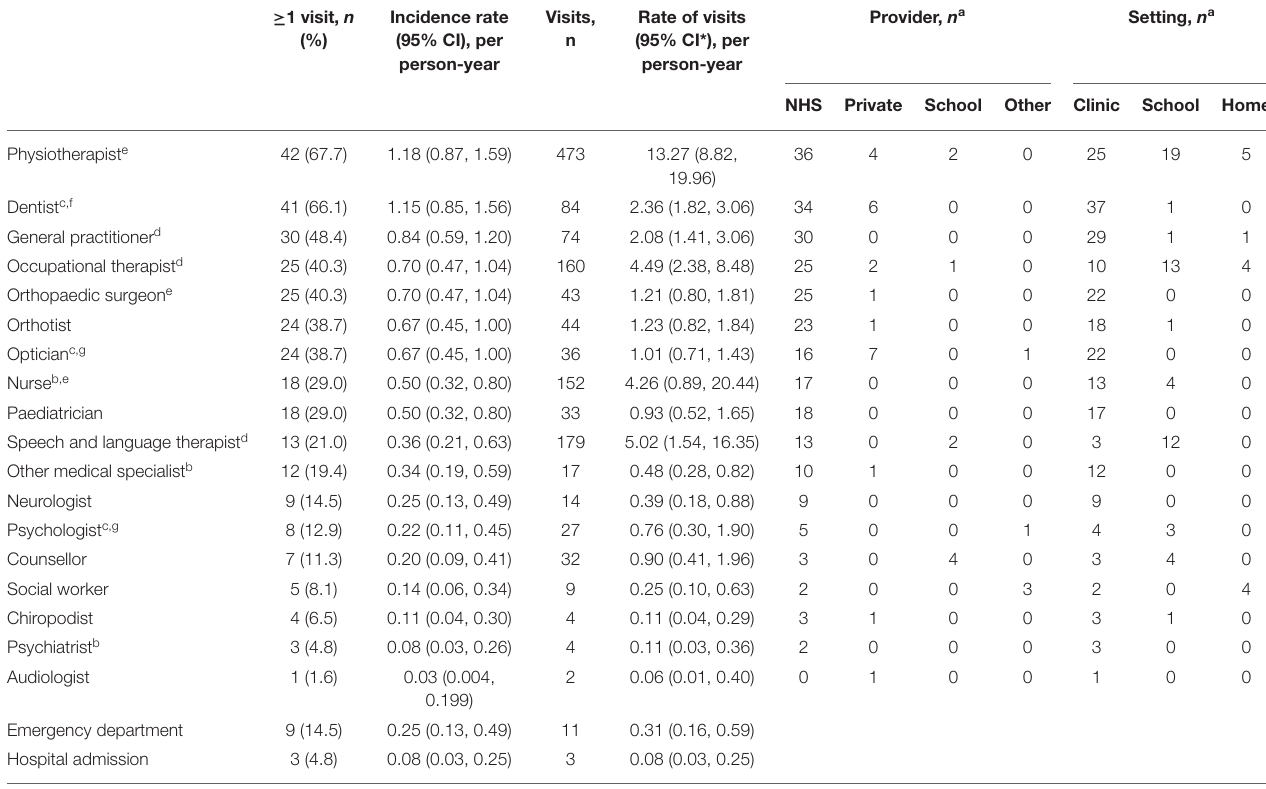
TABLE 2 | Description of visits to each professional, emergency department visits, and hospital